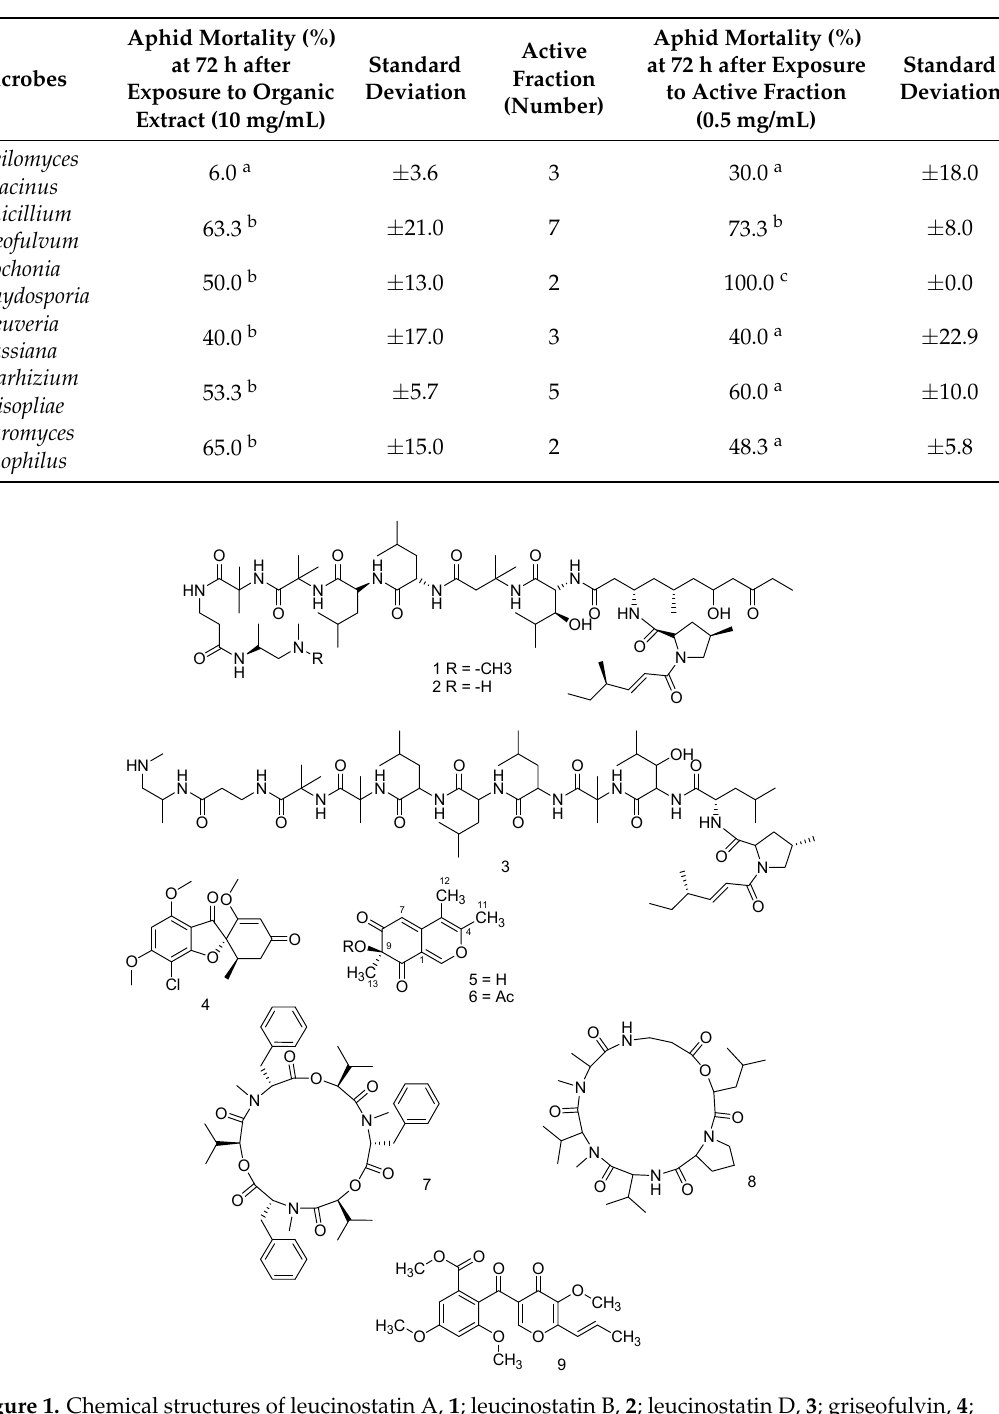
Figure 1. Chemical structures of leucinostatin A, 1 ; leucinostatin B, 2 ; leucinostatin D, 3 ; griseofulvin, 4 ; chlamyphilone, 5 ; Ac-chlamyphilone, 6 ; beauvericin, 7 ; dextrusin B2, 8 ; 3- O -Methylfunicone, 9 .